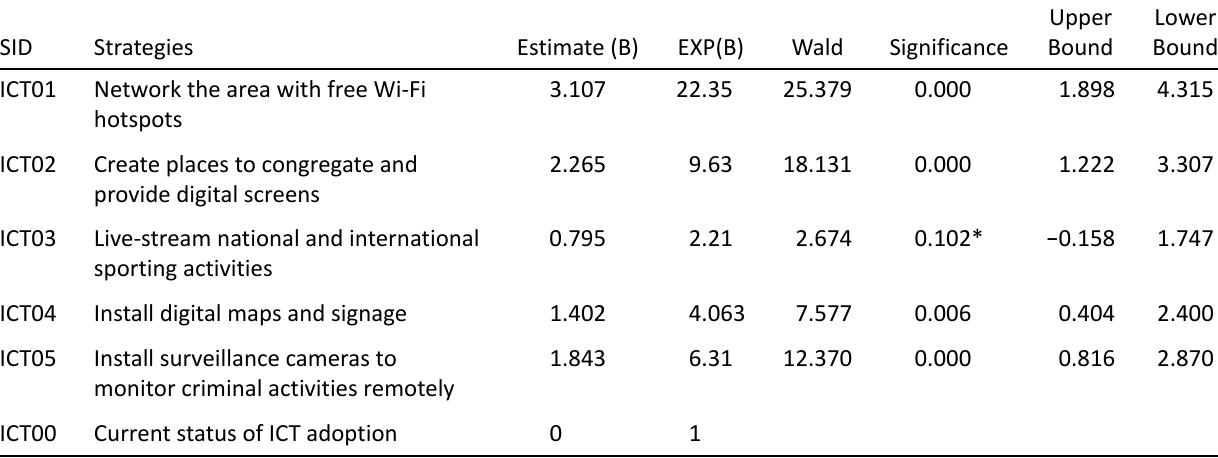
Table 8. Influence of ICT‐related strategies in revitalising the city